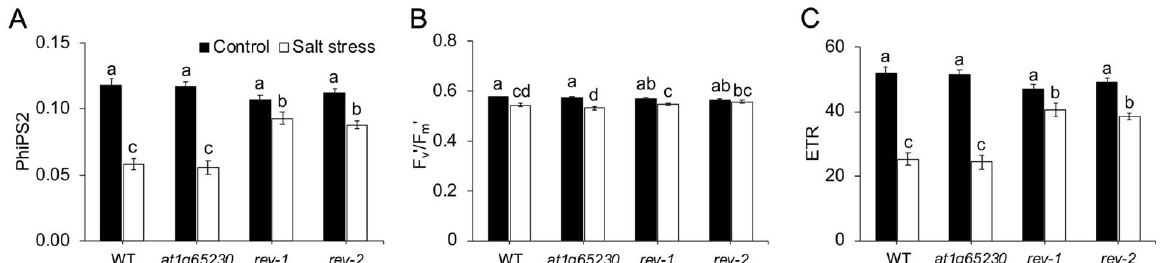
Figure 4. Efficiency of the light reaction in the Arabidopsis wildtype (WT), at1g65230 mutant, and revertant line ( rev-1 and rev-2 ) determined after 10 days of treatment under control and salt stress conditions. Operating efficiency of PSII ( A ), excitation capture efficiency ( B ), and electron transport rate ( C ). The different letters above the bars represent the significant difference among means ( p < 0.05). Error bars show the standard error of 3 replicates.